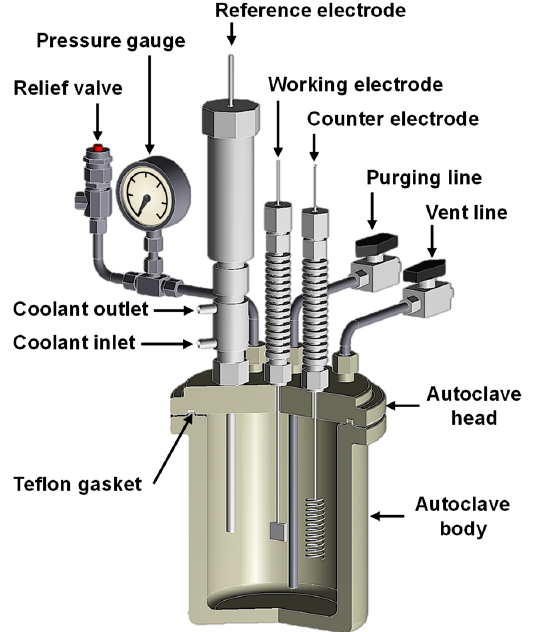
Figure 3. Schematic for the preparation of the magnetite-deposited SCC specimen.